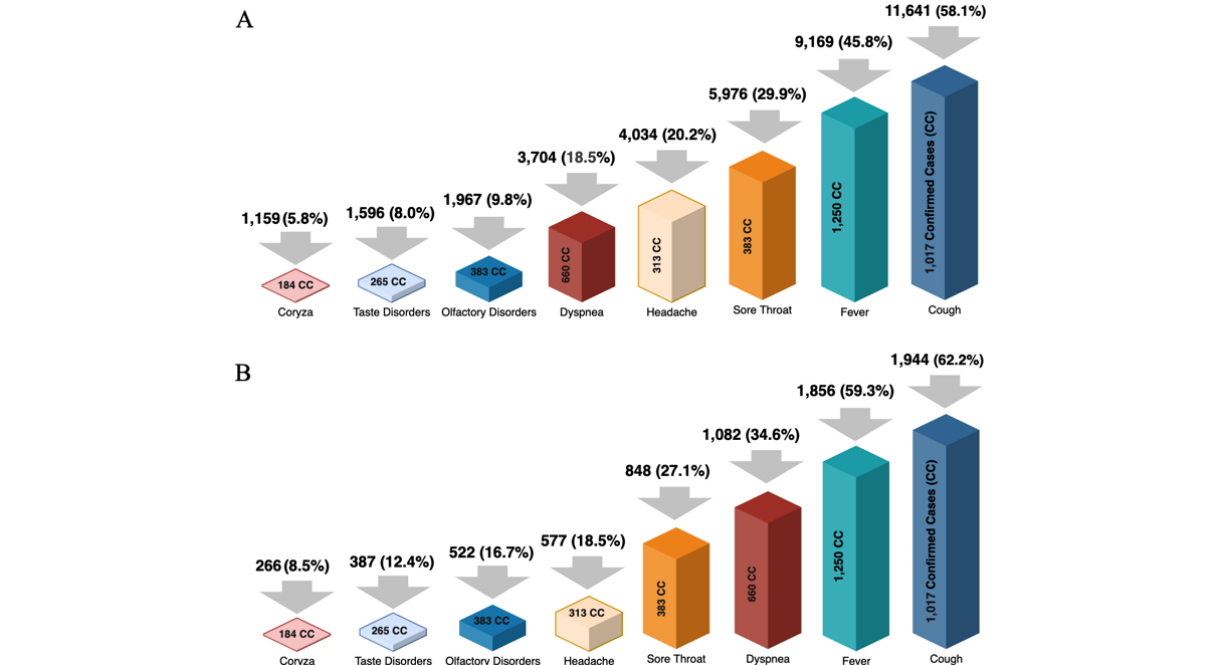
Figure 3. (A) The frequency of symptoms for the 20,021 patients who were symptomatic of the both unbalanced data set and the number of CCs. Top values are frequencies; numbers on the geometric forms are the CC for frequency. (B) The frequency of symptoms for the 3128 patients who were symptomatic of the both balanced data set and the number of